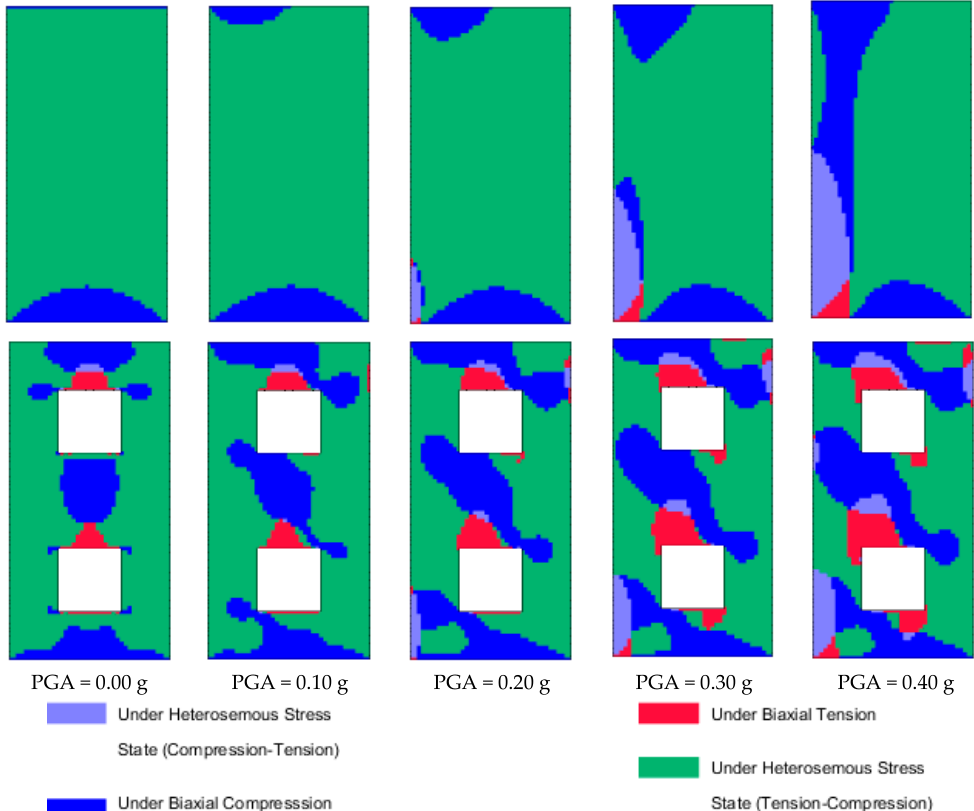
Figure 32. Evolution of the developing stress state in normal stress terms for values of PGA ranging from 0.00 to 0.40 g by step 0.10 g.